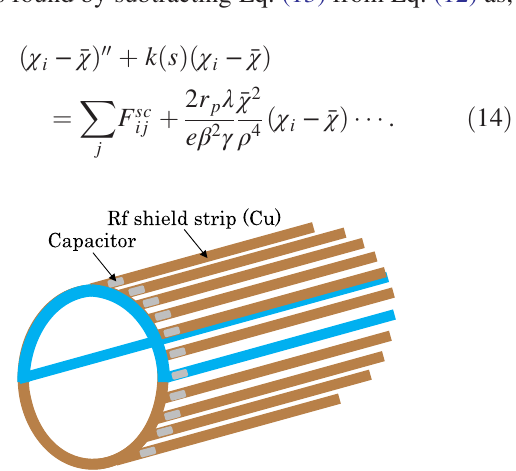
FIG. 15. Schematic drawing of the rf-shielded ceramic